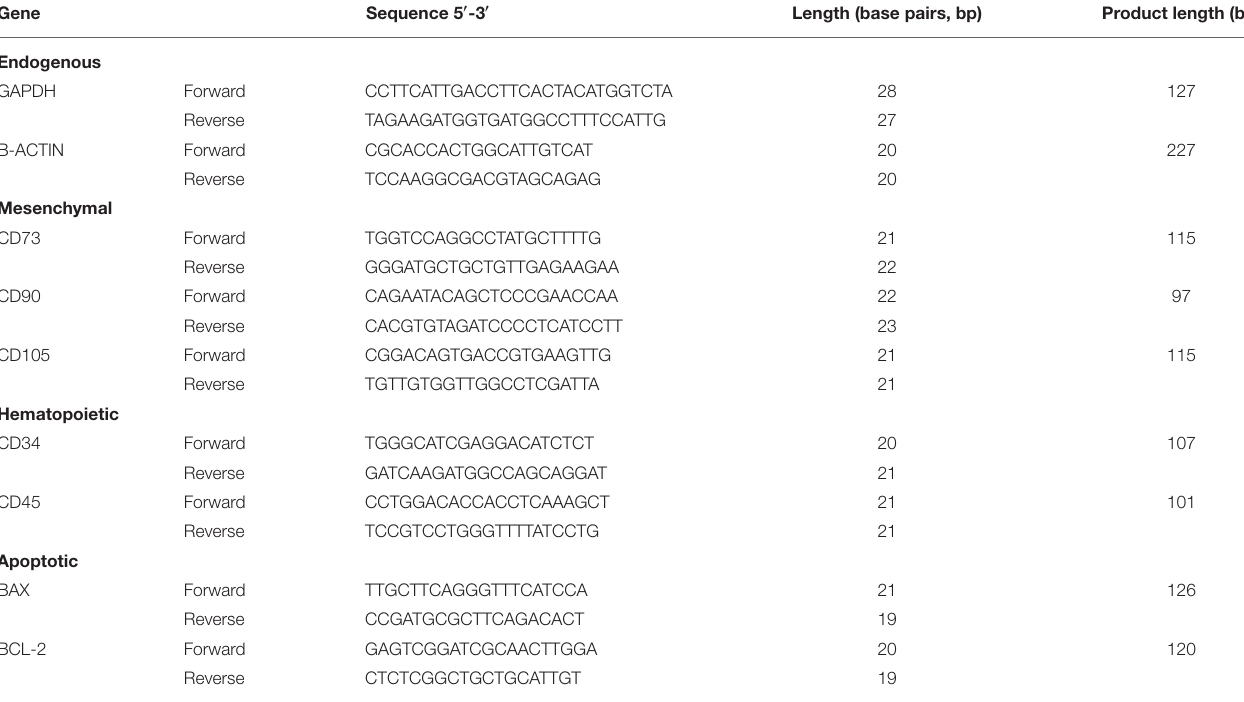
TABLE 1 | Sequences of specific endogenous, mesenchymal, hematopoietic, and apoptotic primers used in qPCR assays. Gene Sequence 5 ′ -3 ′